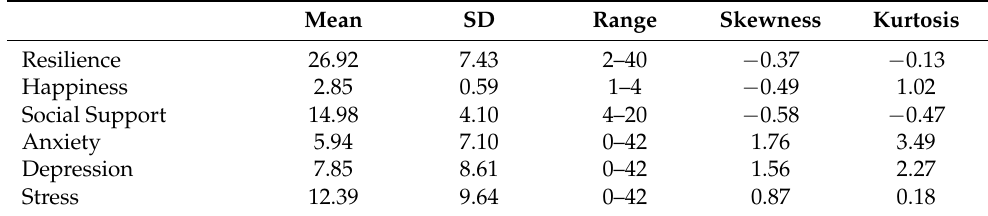
Table 1. Description of the study